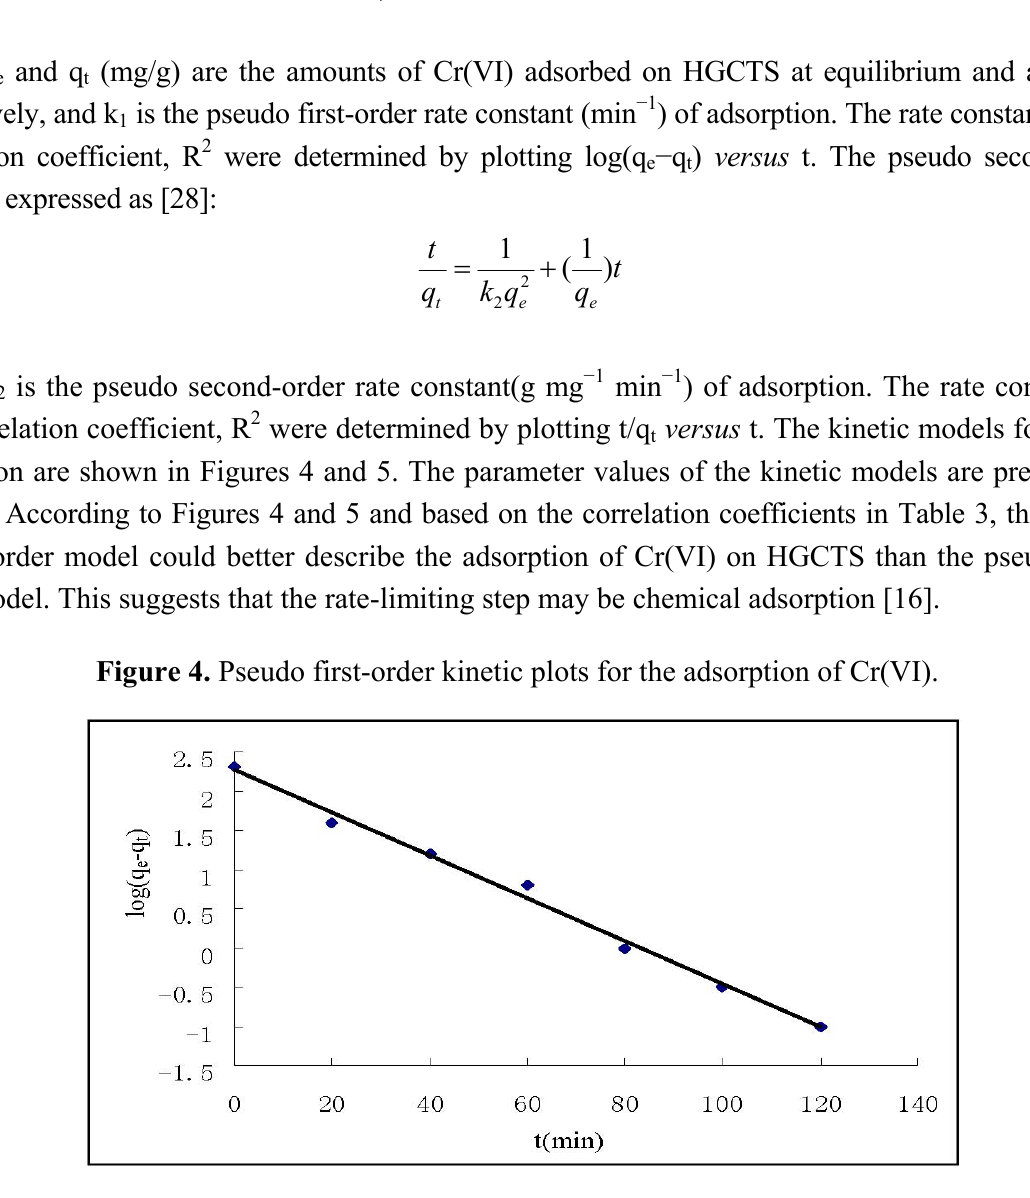
Figure 5. Pseudo second-order kinetic plots for the adsorption of